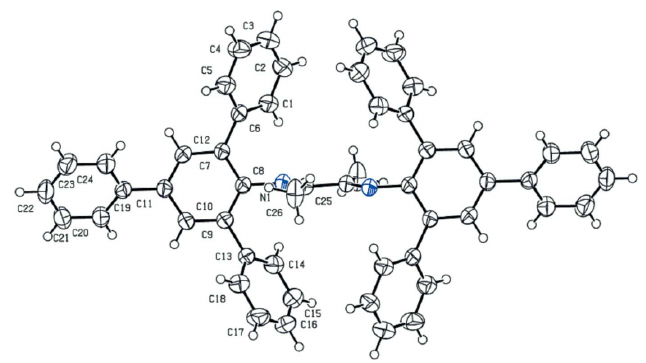
Figure 1 Molecular structure of the title compound showing the atom-labelling scheme and displacement ellipsoids at the 30% probability level. Unlabelled atoms are related by the symmetry operation (cid:5) x , 2 (cid:5) y , 1 (cid:5) z .